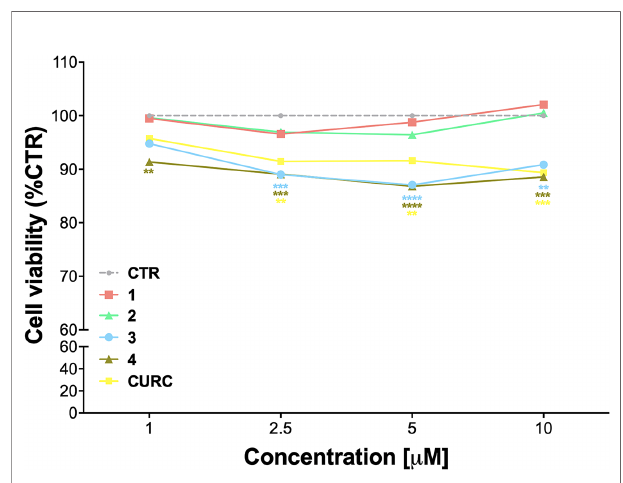
FIGURE 1 | Cell viability in undifferentiated THP-1 exposed to compounds and CURC. THP-1 cells were treated with compounds 1 – 4 and CURC at the indicated concentrations for 24 h. Cell viability was assessed by MTT assay. Data are expressed as means of percentage of cell viability ± SEM. Dunnett ’ s multiple comparison test; ** p < 0.01; *** p < 0.001 and **** p < 0.0001 versus CTR; n =